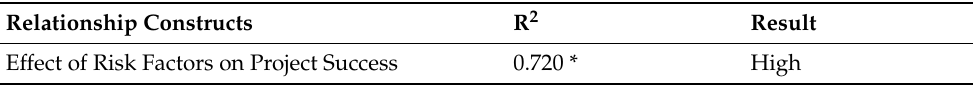
Table 12. Endogenous latent variables R-square.